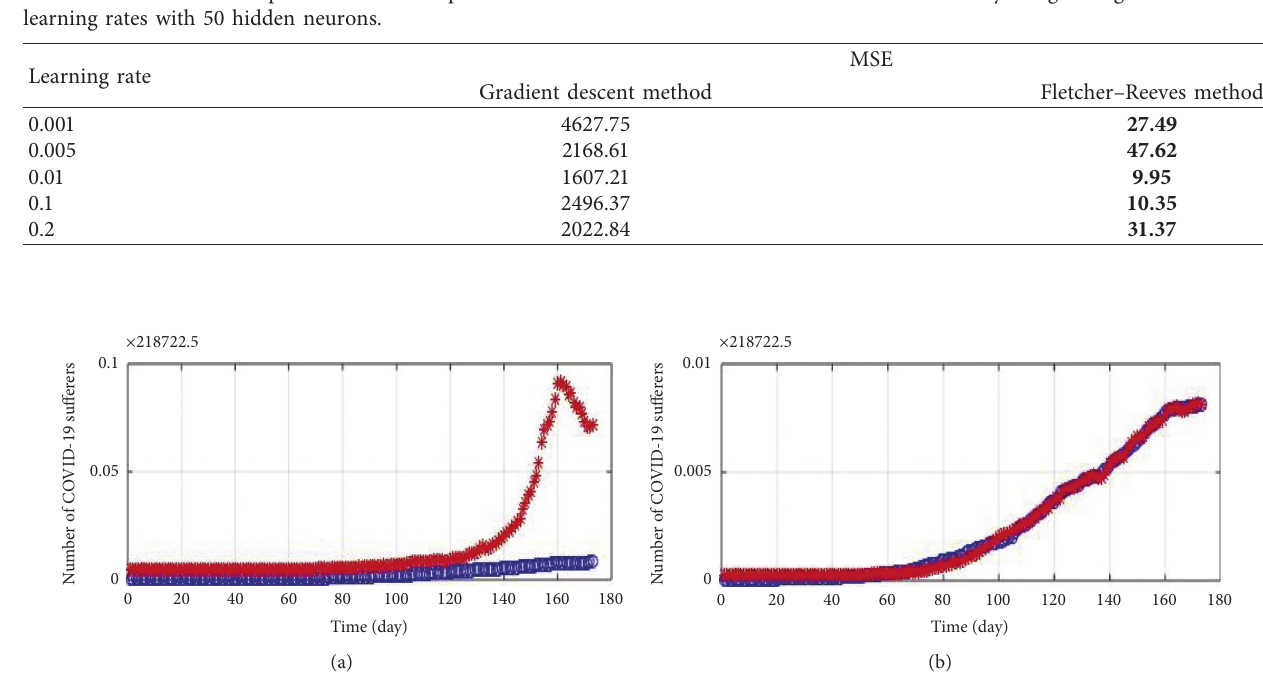
Figure 3: Comparison between the number of COVID-19 sufferers from the actual data and the number of COVID-19 sufferers predicted by the Backpropagation algorithm for training data. (a) Backpropagation neural network with the gradient descent method. (b) Back- propagation neural network with the Fletcher–Reeves method.